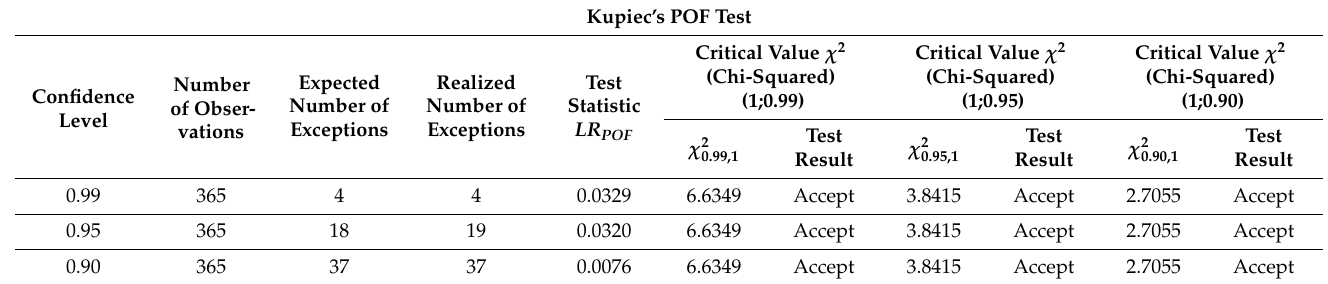
Figure 3. BTC daily return and historical simulation VaR. Table 2. Historical simulation VaR Kupiec’s